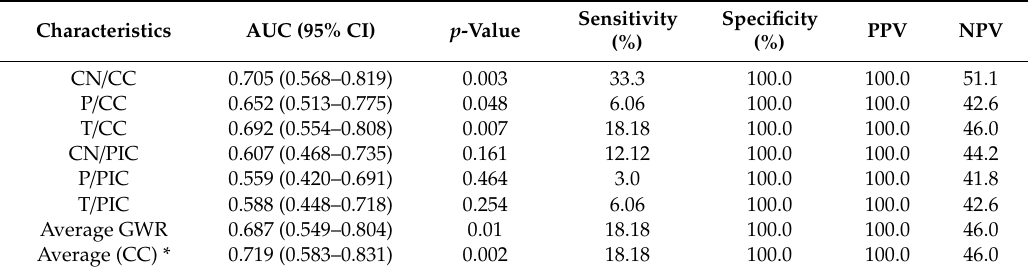
Table 4. Prognostic performances of grey matter-to-white matter ratios in brain CT for predicting three-month poor neurological